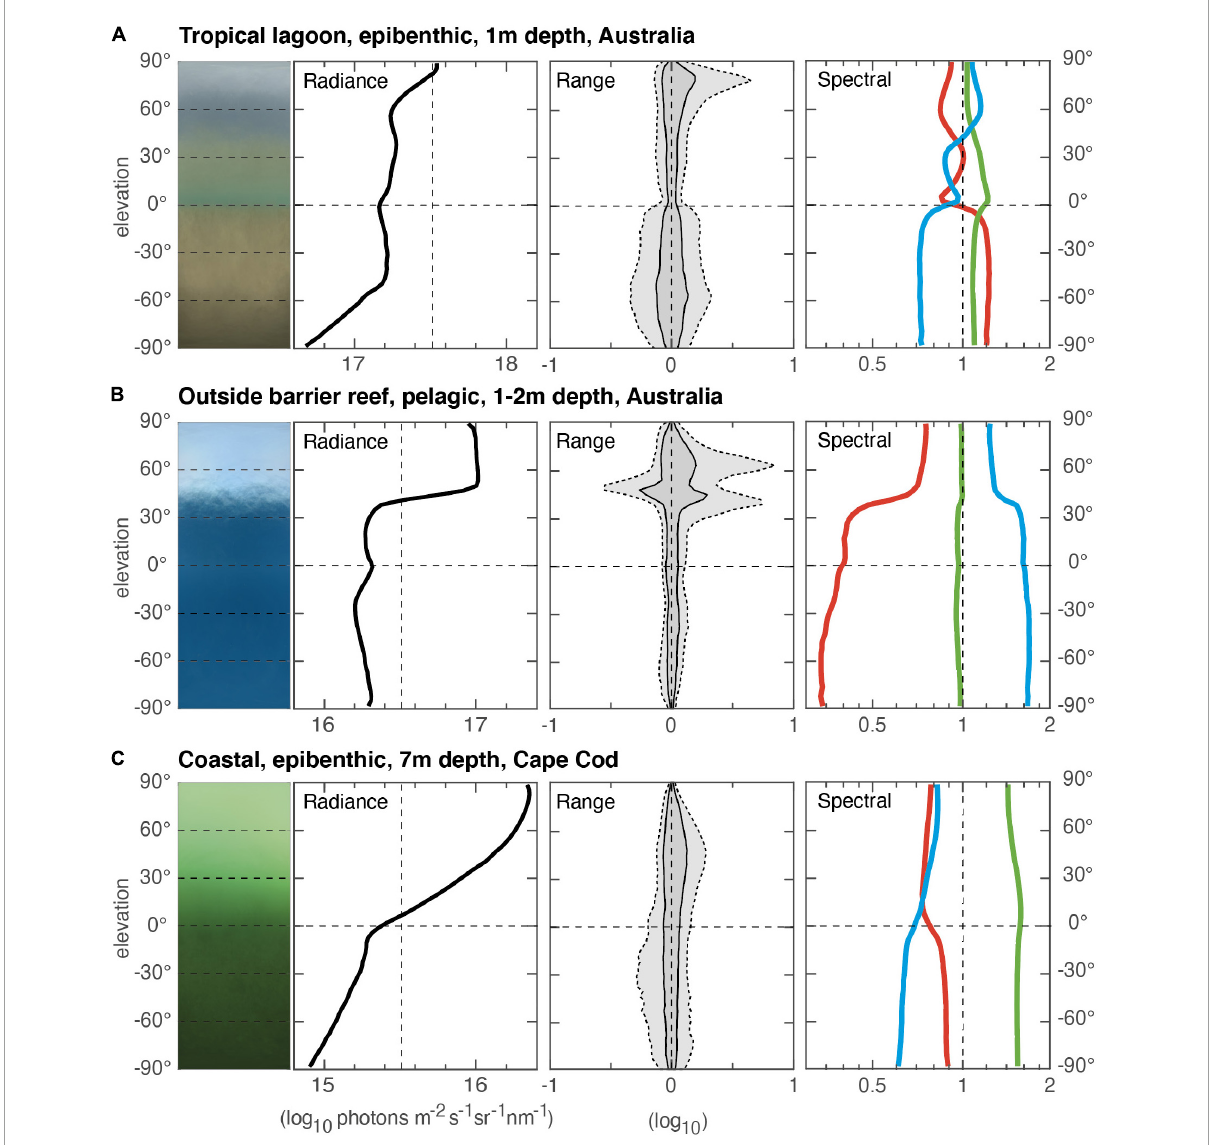
FIGURE4 Shallow aquatic environments. (A) A tropical lagoon at Lizard Island, Queensland, Australia (measurement based on 40 scenes, 7 September 2015, start 12:17, duration 12 min). The environment was sampled at 1 m depth close to the bottom in the shallow lagoon. (B) Outside the barrier reef, at 1–2 m from the surface, over deep water with no visible seafloor, Queensland coast, Australia (measurement based on 27 scenes, 4 September 2015, start 14:31, duration 11 min). (C) Coastal epibenthic environment at 7 m depth outside Cape Cod, Massachusetts, United States (measurement based on 24 scenes, 19 October 2016, start 15:52, duration 8 min). All environments, (A–C) , were measured on clear, sunny days. In panels (A,B) , the sun was at least 45 ◦ above the horizon, and in panel (C) , 20 ◦ C above the